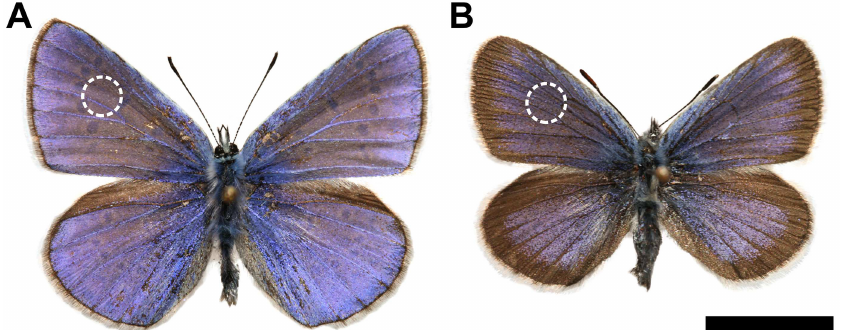
Fig 1. Color photographs of male Blue butterflies. (A) Polyommatusicarus (Common Blue) and (B) Plebejusargus (Silver-studded Blue) specimensare shown. The dashedcircles show the location of the integratingspheremeasurements. The measurement location is marked only on the left forewings.Scale bar: 10 mm.